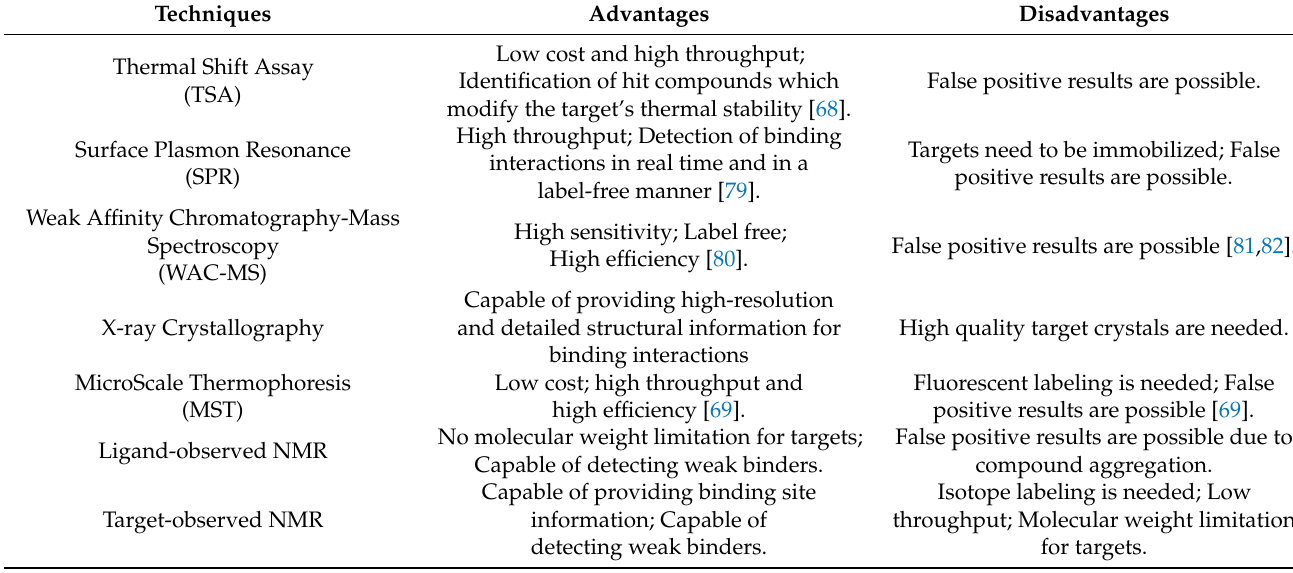
Table 1. Advantages and disadvantages of some techniques applied in fragment-based drug discovery (FBDD).